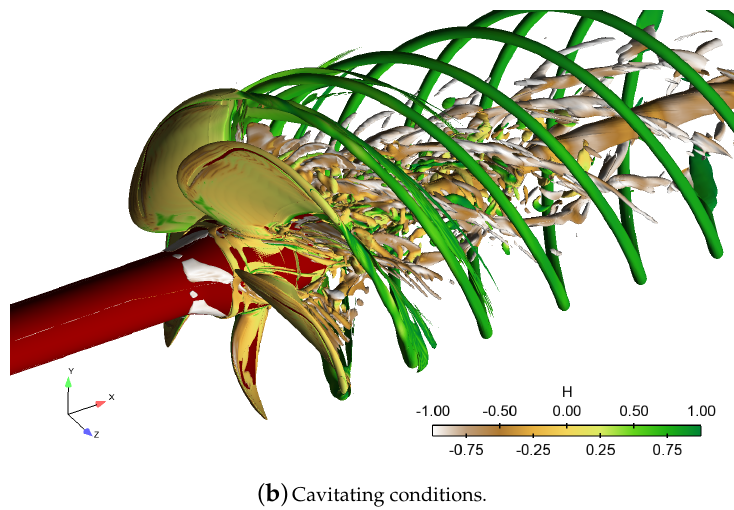
Figure 17. Vortical flow structures visualized near the propeller by means of the Q criterion. The iso-surface of the Q criterion is coloured by helicity.